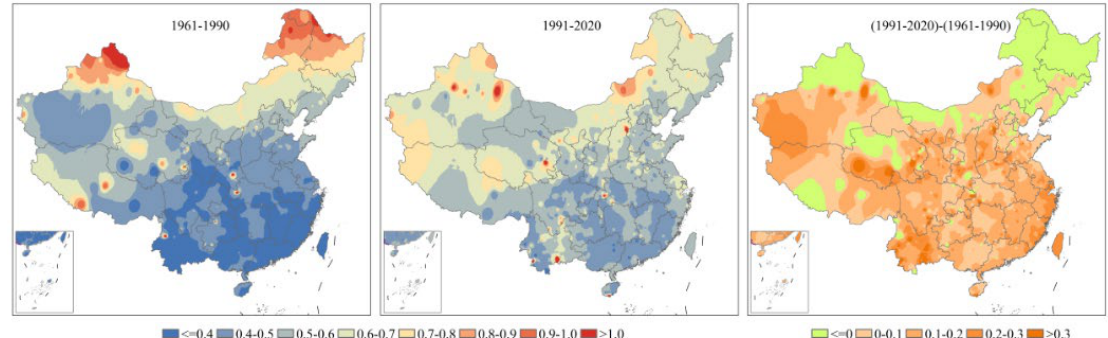
Figure 7. Variation in mean air temperatures during the potential agricultural growing season for the indicated time periods.